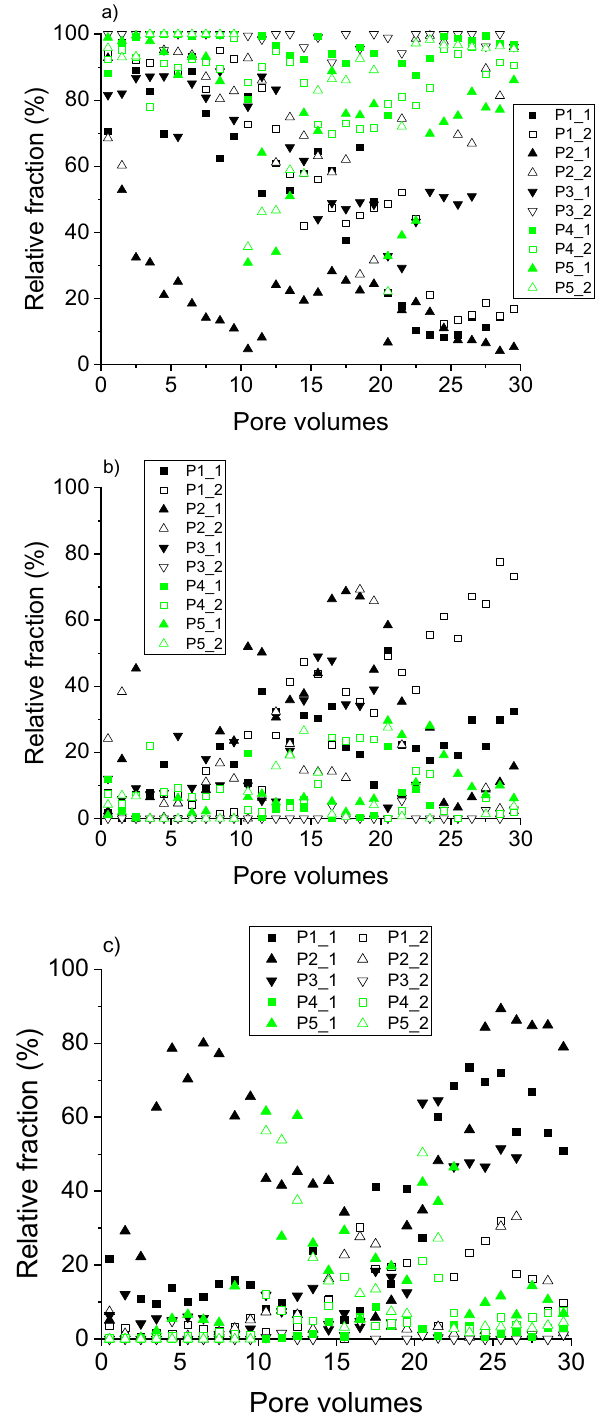
Figure 5. Relative distribution of silicon eluted from soils with increasing degrees of podzolisation (P1 to P5) in irrigation experiments between fractions. ( a ) < 1 kDa, ( b ) 1 kDa–0.45 µm, ( c ) > 0.45 µm. ‘_1’ and ‘_2’ denote duplicate